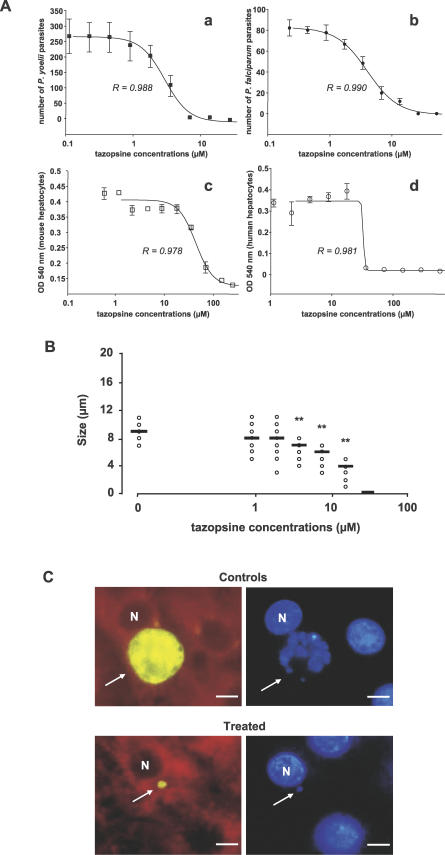
Inhibitory Activity of Tazopsine on Plasmodium Hepatic Stages in vitro(A) Representative curve of the dose-dependent inhibition of tazopsine (the number of parasite forms in test wells divided by the number of parasites in control wells) for graph a, P. yoelii (filled squares [], average number in control wells = 274), and graph b, P. falciparum (filled circles [•], average number in control wells = 83). Toxicity as assessed by the neutral red assay is presented for graph c, mouse (open squares [□]), or graph d, human (open circles [○]) primary hepatocytes. Results are means ± standard deviation within triplicates of one experiment. R represents the factor of regression calculated by SigmaPlot.(B) Dose-dependent influence on the size of surviving P. falciparum hepatic forms, (21 forms were counted for each point, and the bar represents the median value). Significance was calculated in one-way ANOVA analysis for the whole dataset (p < 0.0001), coupled to a Tukey HSD test: double asterisks (**) indicate p < 0.01.(C) P. falciparum hepatic forms (arrow) from cultures treated with tazopsine (15 μM) for 5 d, or untreated control cultures. DAPI staining is shown in the right images, and P. falciparum–specific staining (anti-PfHSP70 antibodies) in the left images. N, hepatocyte nucleus. The bar represents 5 μm.